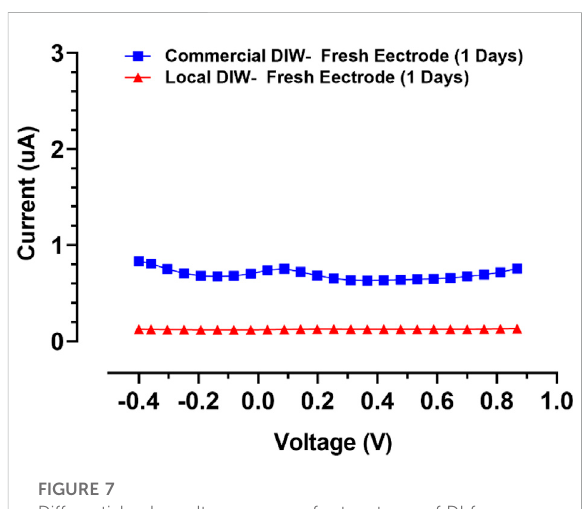
FIGURE 7 Differential pulse voltammograms for two types of DI for evaluation of fresh SPE ’ s